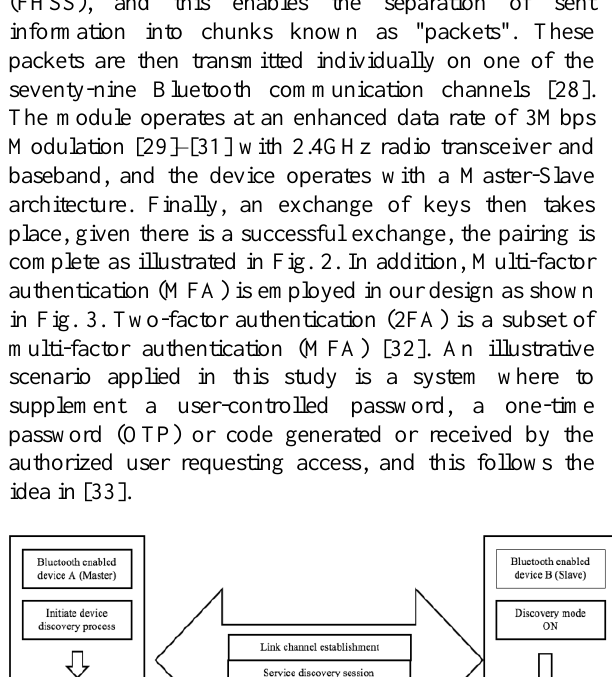
Fig. 4. Python code snippet for audio sampling